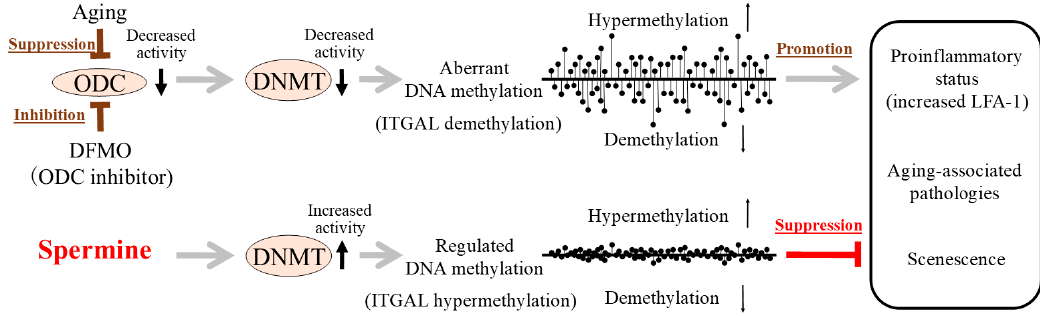
Figure 2. Aging, ODC activity, DNA methyltransferase (DNMT) activity, gene methylation status, and progression of aging associated pathologies and senescence (summary of the results of our previous studies).(Upper) Aging is associated with decreases in ODC and DNMT activities, increased aberrant methylation status (increased demethylation in certain areas and increased hypermethylation in other areas) of entire genome, and enhanced pro-inflammatory status. D,L-alpha-difluoromethylornithine (DFMO)-induced ODC inhibition caused decreased DNMT activities, increased aberrant methylation, increased demethylation of the LFA-1 promoter area (ITGAL), and enhanced pro-inflammatory status (increased LFA-1 protein). (Lower) Spermine supplementation reversed changes induced by the inhibition of ODC by DFMO. Increased polyamine intake elevated blood spermine levels in mice and humans, and lifelong intake of high-polyamine chow inhibited aging-associated increase in aberrant DNA methylation and LFA-1 expression, inhibited aging-associated pathologies, and extended lifespan of mice. DFMO: D,L-alpha-difluoromethylornithine, ODC: ornithine decarboxylase, DNMT: DNA methyltransferase, ITGAL: promoter area of LFA-1, LFA-1: lymphocyte function-associated antigen 1.